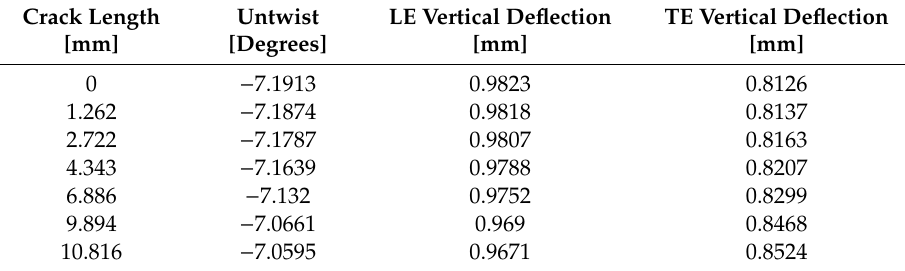
Table 7. Deformation results for the 60° short flank geometry.